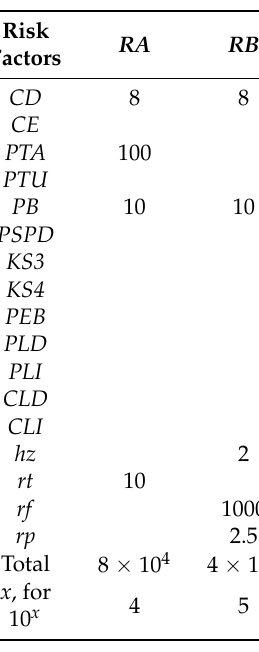
Table 12. Accumulated Variation of Risk Values for Risk